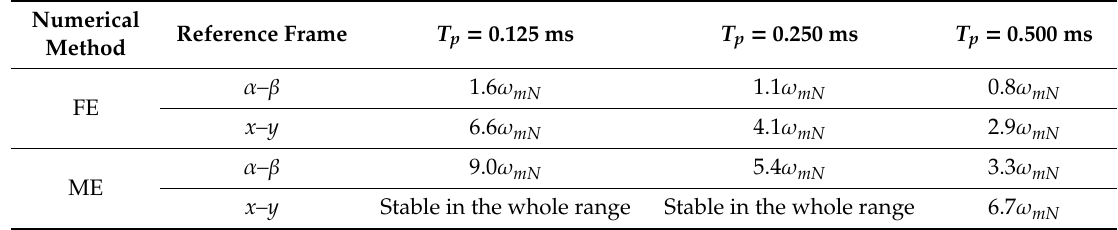
Table 1. Stable operation range of the discrete classical MRAS CC estimator ( m L =